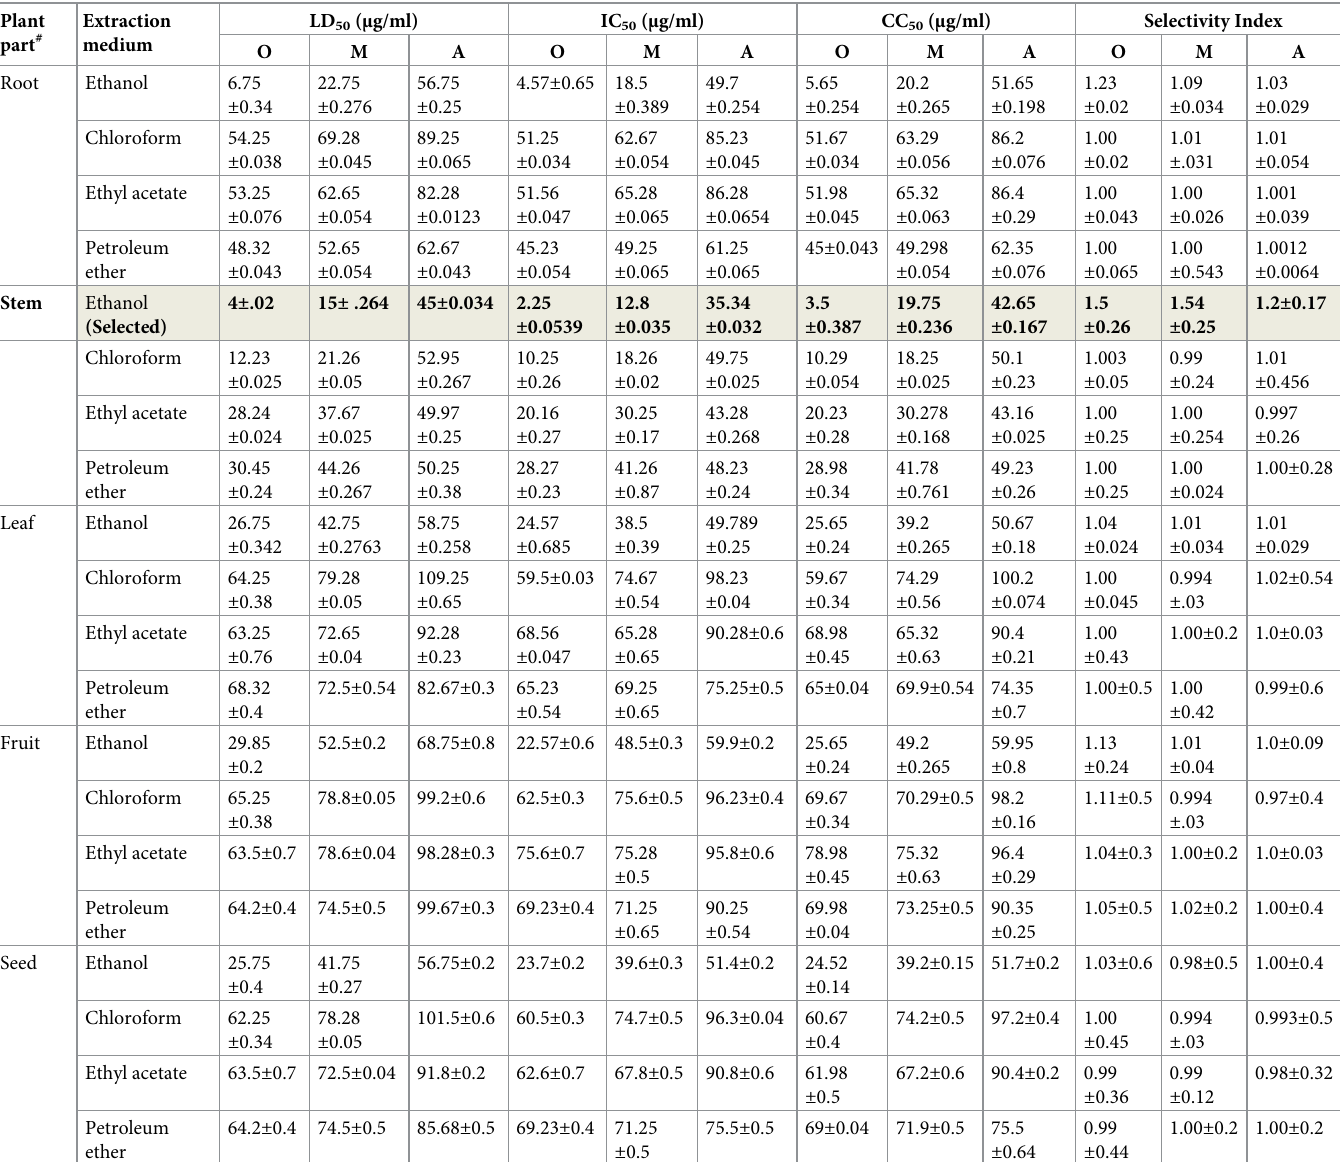
Table 1. Evaluation of antifilarial activity in different solvent extracts (crude) of Cajanus scarabaeoides . Extraction Plant medium part #